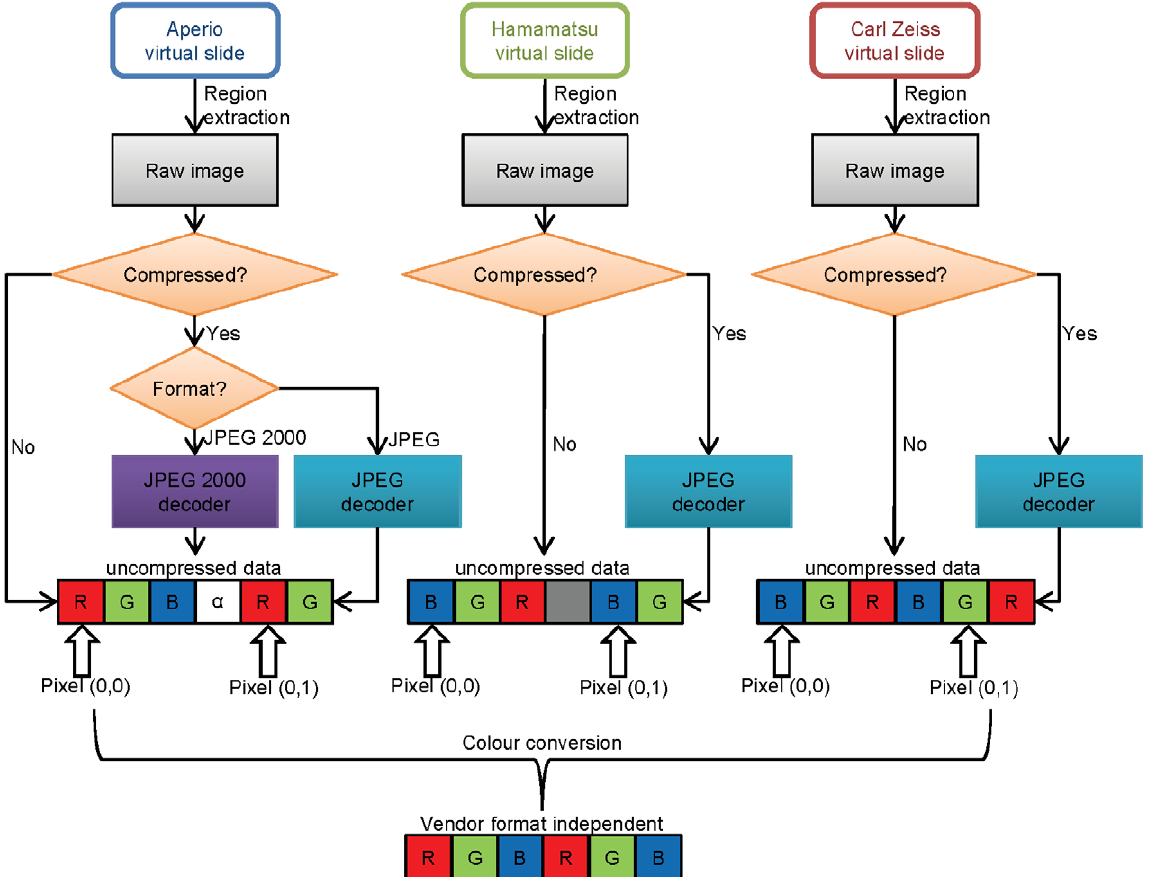
Fig. 3. Flowchart of how the File Access module loads virtual slides. Currently Virtual slides produced using Aperio, Hamamatsu and Carl Zeiss scanners are supported. Regions of these virtual slides are initially loaded into memory and subsequently decompressed using their corresponding decompression method. Finally, these uncompressed data are converted into vendor format independent RGB format. (Colours are visible in the online version of the article; http://dx.doi.org/10.3233/ACP-CLO-2010-0551.)